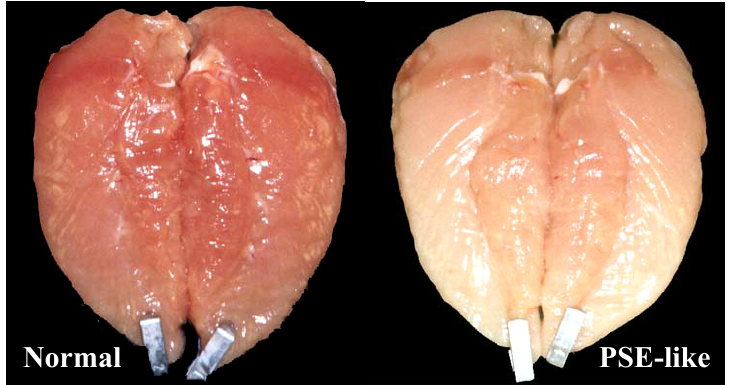
Figure 2. Pale, soft and exudative (PSE)-like broiler breast